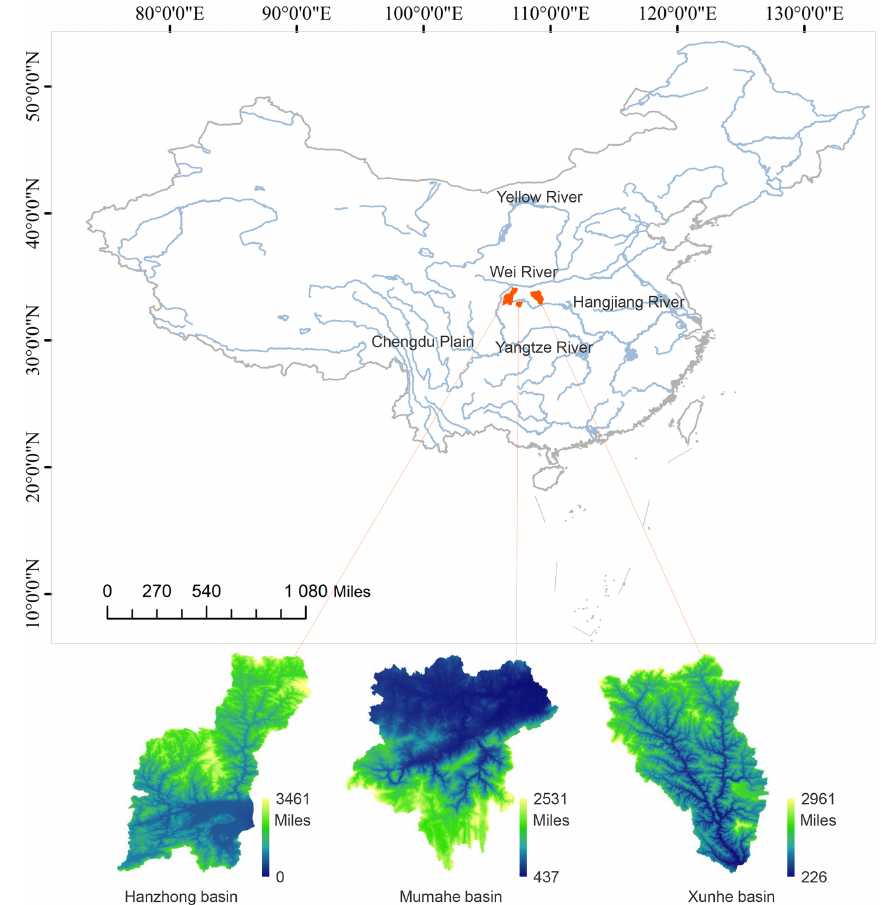
Figure 1. Locations in the study